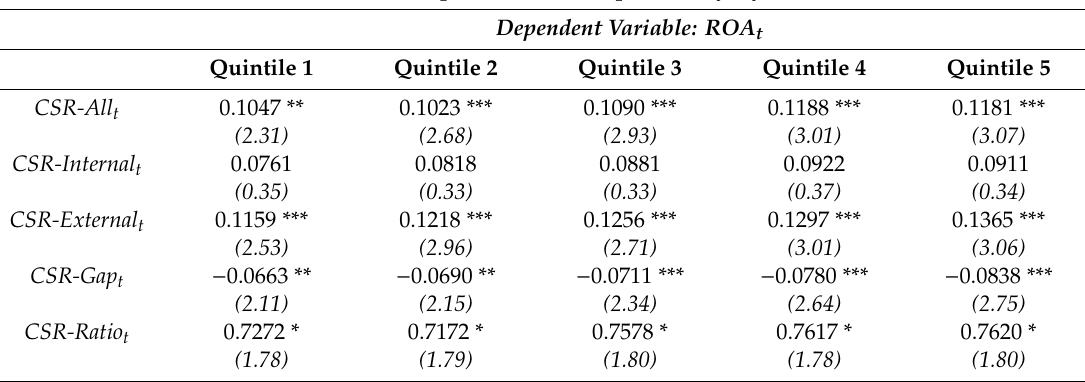
Table 8. Bank Performance and Corporate Social Responsibility, by bank size. This table presents the OLS results from estimating equation (1), the impact that CSR has on bank performance, sorted by bank size (Total Assets). In Panel A, bank performance is measured by Return on Assets, or ROA, across five size quintiles. In Panel B, bank performance is measured by Tobin’s Q, across five quintiles. In each panel, while the full Equation (1) model is estimated within size sub-sample, only the coe ffi cients and t-statistics associated with the CSR variables are presented for conciseness. The primary explanatory variables are CSR-All, CSR-Internal, CSR-External, CSR-Gap and CSR-Ratio. These and all other variables are defined in Appendix A. Standard errors are clustered at the firm level. Intercepts and firm and year fixed e ff ects are included in the model but not tabulated. Coe ffi cients are presented with t-statistics below in parentheses. Statistical significance is indicated with *** for 1%, ** for 5% and * for 10%. Panel A: ROA and Corporate Social Responsibility, by bank